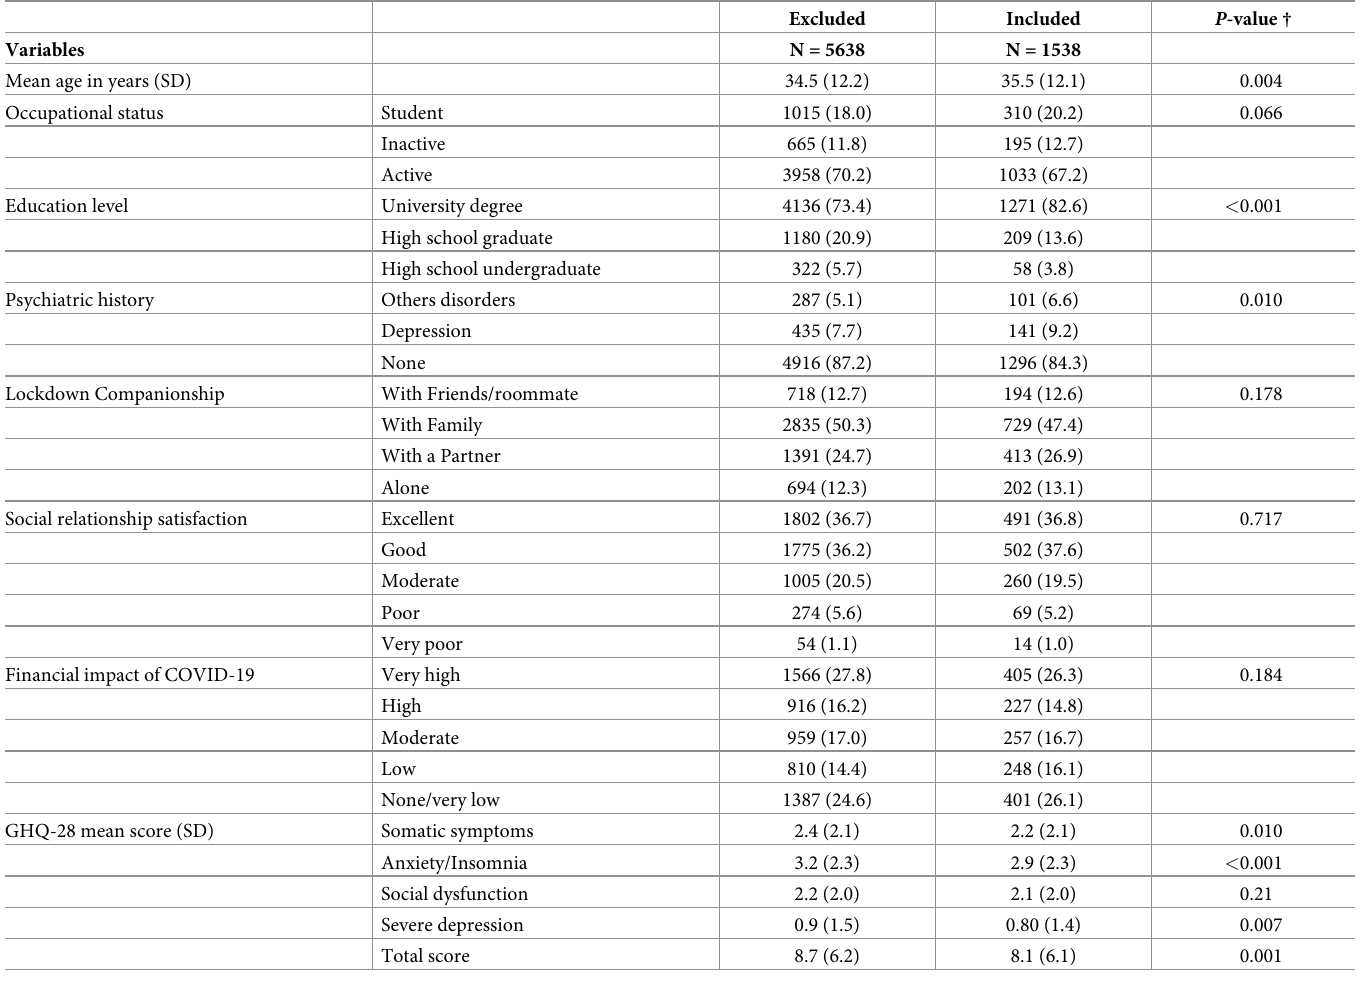
Table 1. Sociodemographic of female respondents according to study participation and inclusion (N = 1538).